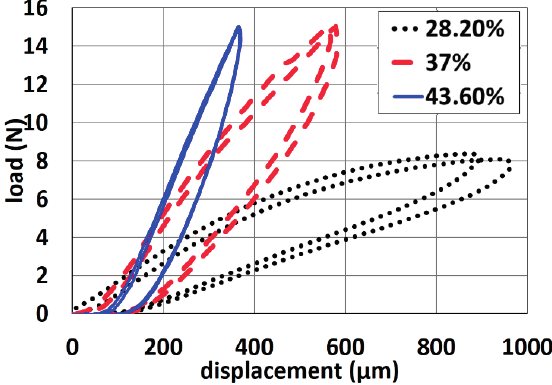
Figure 8. Load-displacement curves of pin-shaped electrodes containing various carbon